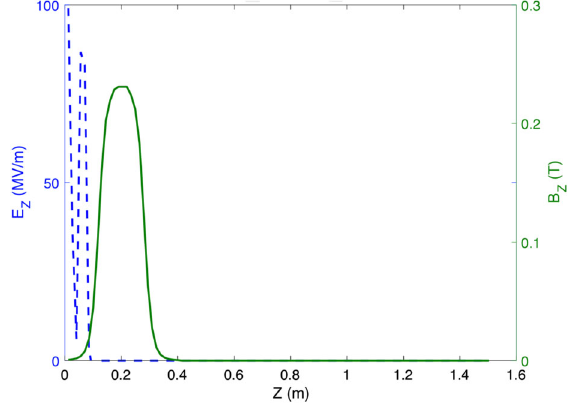
FIG. 5. rf (blue dashed line) and solenoid (green line) fields as seen by the central slice of the electron beam used for the ASTRA simulation. The beam emittance is calculated at the entrance of solenoid, at Z ¼ 0 . 13 m where the electron beam has a constant value of Lorentz